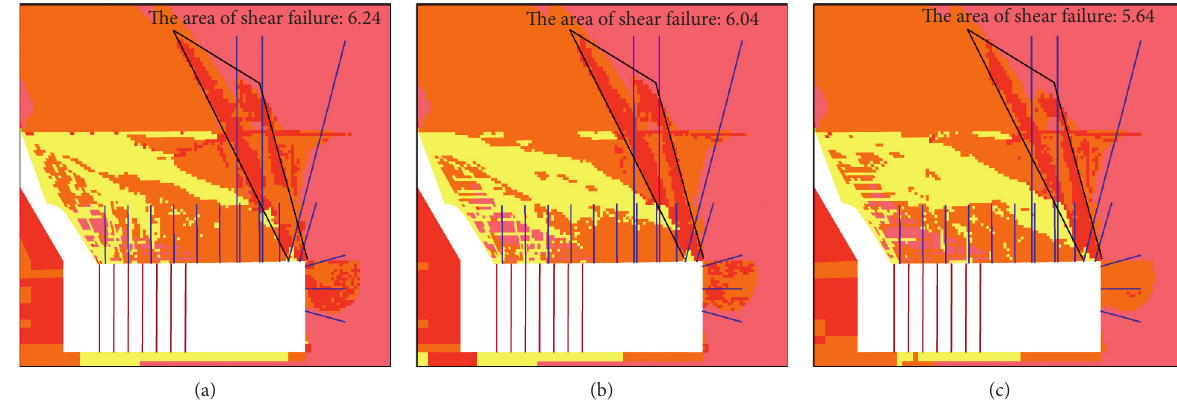
Figure 13: WRS influencing the shear failure around removal area. (a) 6000kN. (b) 8000kN. (c) 10000kN.